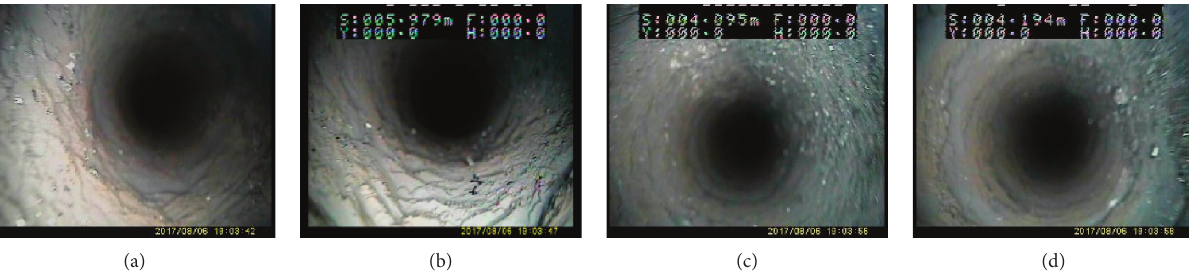
Figure 13: The distribution of the surrounding rock in the roof anchorage area. (a) 0.2m. (b) 0.9m. (c) 1.8m. (d) 2.2m.